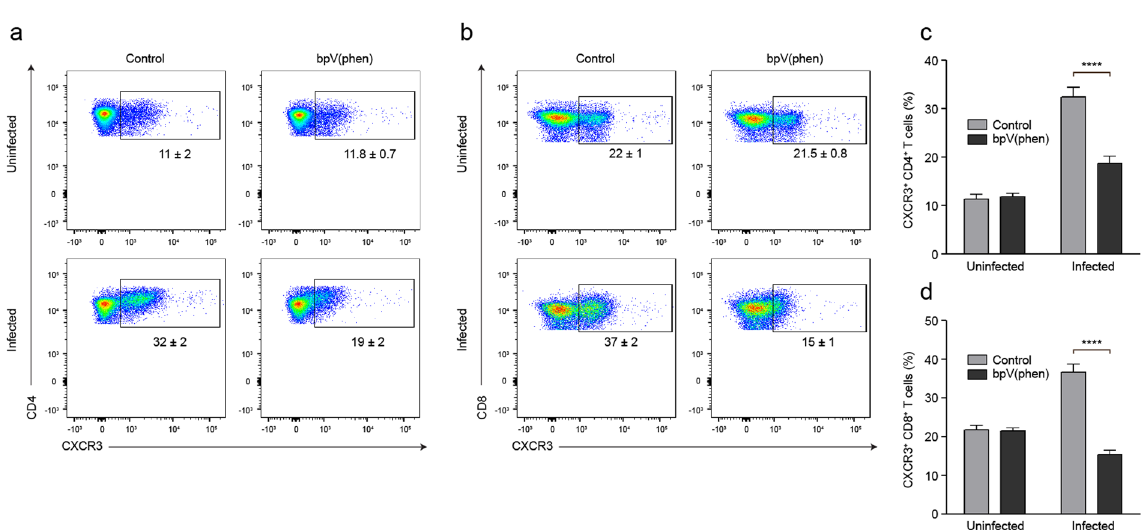
Figure 6. bpV(phen) treatment attenuates the expression of CXCR3 on splenic CD4 + and CD8 + T cells. Representative flow cytometry plots of CXCR3 + ( a ) CD4 + and ( b ) CD8 + T cells, and the percentage of CXCR3 + ( c ) CD4 + and ( d ) CD8 + T cells measured on day 7 post-infection. The numbers shown on the flow cytometry plots indicate the mean percentage of cells inside the gate ± S.E.M. The cumulative average of 2 independent experiments is shown. n = 9 for uninfected, control mice, n = 10 for uninfected, bpV(phen)-treated mice, n = 9 for infected, control mice, and n = 9 for infected, bpV(phen)-treated mice. **** P < 0.0001 using a one-way ANOVA and Tukey’s multiple comparisons